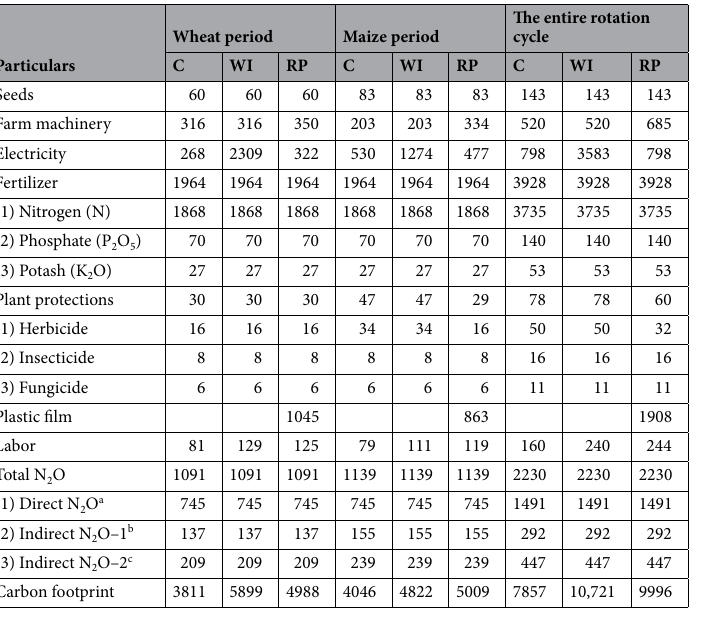
Table 3. Effect of different planting patterns on GHG emissions (kg CO 2 –eq ha –1 ) of wheat–maize cropping system. C, conventional rain–fed flat planting; WI, well-irrigation planting; RP, ridge-furrow planting with plastic film mulch over the ridge. a Direct N 2 O, direct N 2 O emission from N fertilizer on upland crops. b Indirect N 2 O–1, indirect N 2 O emission from synthetic N fertilizer volatilization. N 2 O emission from N fertilizer